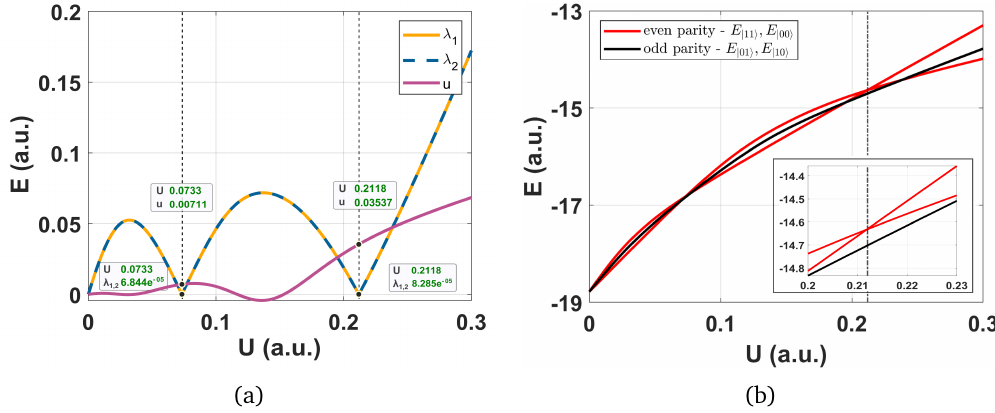
Figure 5: The optimal point parameters obtained for a N = 10 site Kitaev chain = 4, n = 7) obtained following the method model (non-topological segment: n nt 1 nt 2 of finding approximate SYK point by minimizing MZM wave function overlap to zero = 0.4832, µ = 0.4832, as described in Section 5.1 are: t = 0.4025, ∆ = 0.2167, µ t1 t2 µ = 8.5364. (a), We sweep across U at the optimal point and find a couple of SYK nt points at U = 0.0733 and U = 0.2118. At the best SYK point, i.e. at U = 0.2118, (cid:39) 8.28 e − 5 and u (cid:39) 0.036. (b), We plot the lowest four energy levels we have λ , λ 1 2 vs U labelled by their parities (even-red, odd-black). At the best SYK point obtained at U = 0.2118 (shown in inset), that the two even and the two odd parity states are degenerate (level-crossings) while the energy gap between between different parity states is at a